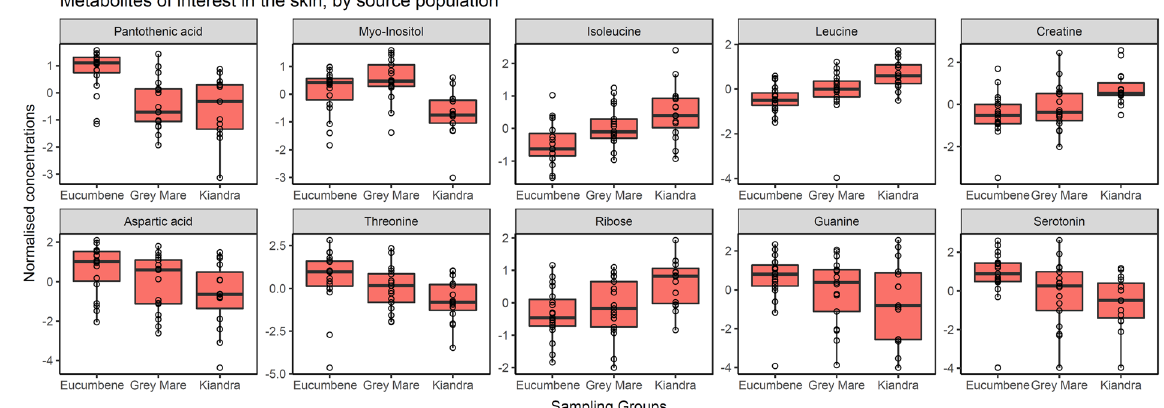
Figure 5. Box and whisker plots (with data points overlaid) of the relative concentration of identified metabolites of interest from skin samples according to their population of origin (using geom_boxplot from ggplot2 R package). Box hinges represent first and third quartiles, and middle represents the median. Whiskers extend 1.5 times the inter-quartile range of the hinge. Boxes are ordered by relative metabolite importance.